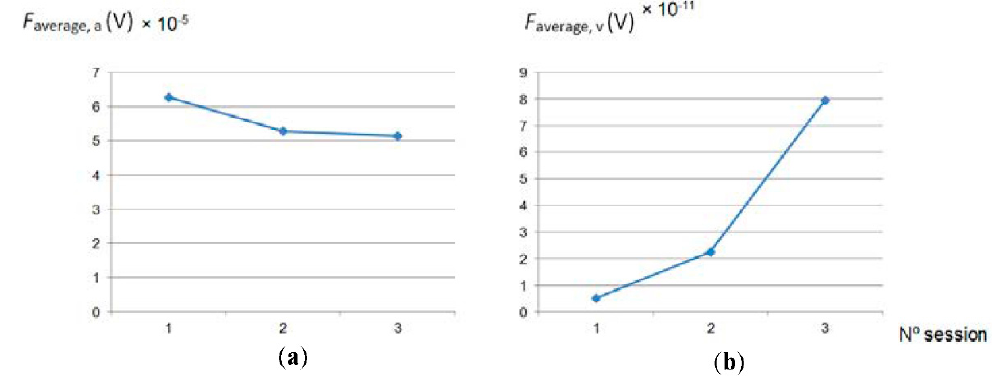
Figure 5. Signal: ( a ) arithmetical average and ( b ) variance, calculated from signal forces average versus number polishing session.